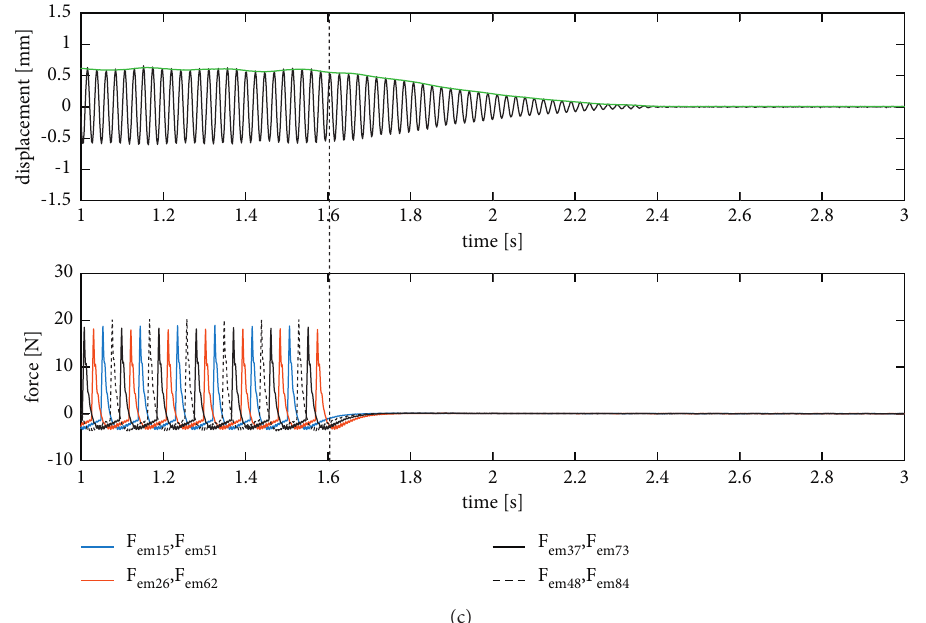
Figure 8: Vibration attenuation: mode 2ND, 334rpm contact prestress 2 N. (a) Test no. 3. (b) Test no. 2. (c) Test no.